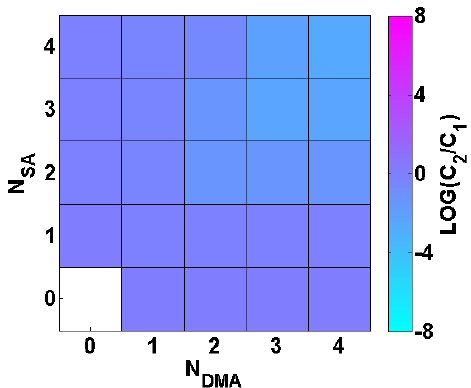
Fig. 9. The differences in cluster concentrations when the collision sticking probabilities of the most prevalent clusters in the system are reduced to 0.1. The colour scale gives the base-10 logarithm of the ratio of the concentrations when compared to the standard